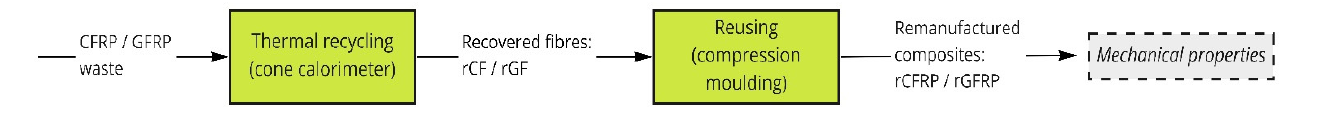
Figure 1. Performed thermal recycling route (modified from [24]).